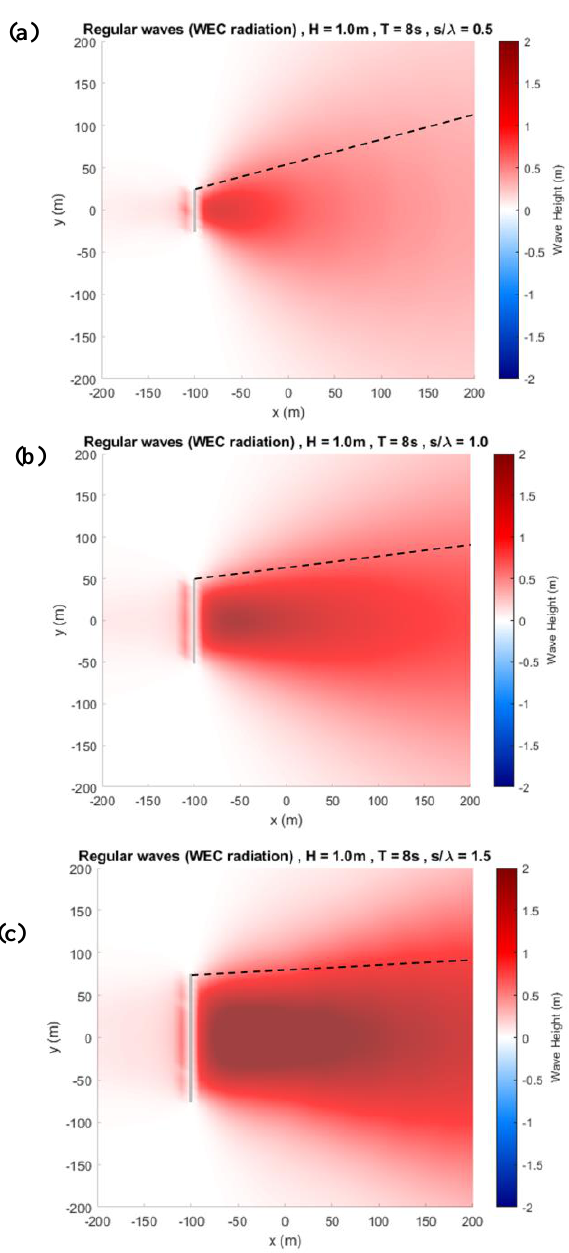
Figure 4: The time averaged wave height of the radiated wave field for a regular wave for different WEC spans, (a) 𝑠 𝜆⁄ = 0.5 , (b) 𝑠 𝜆⁄ = 1.0 , and (c) 𝑠 𝜆⁄ = 1.5 . The dashed line represents the spreading